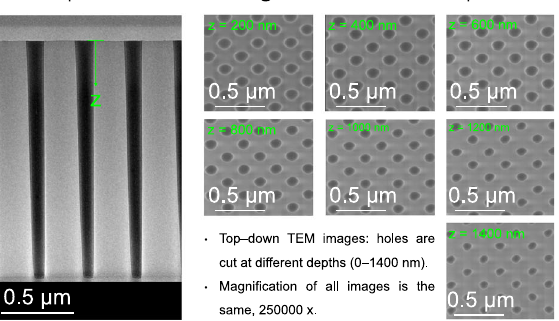
Fig. 5 | 100 nm TiO 2 ALD deposited in holes with and without TMPMCT inhi- bitor. a Cross-sectional TEM images of the hole pattern (depth=1600 nm) for 100nm TiO 2 ALD without TMPMCT. Un fi lled zones are observed at the bottom (zone 4), and seam formation occurs along the centreline of the hole (zones 2 and 3). b Cross-sectionalTEM images of the 100nm TiO 2 ALD/60s TMPMCT/SiO 2 hole and top-down TEM images at different depths, demonstrating hole fi lling without any seam